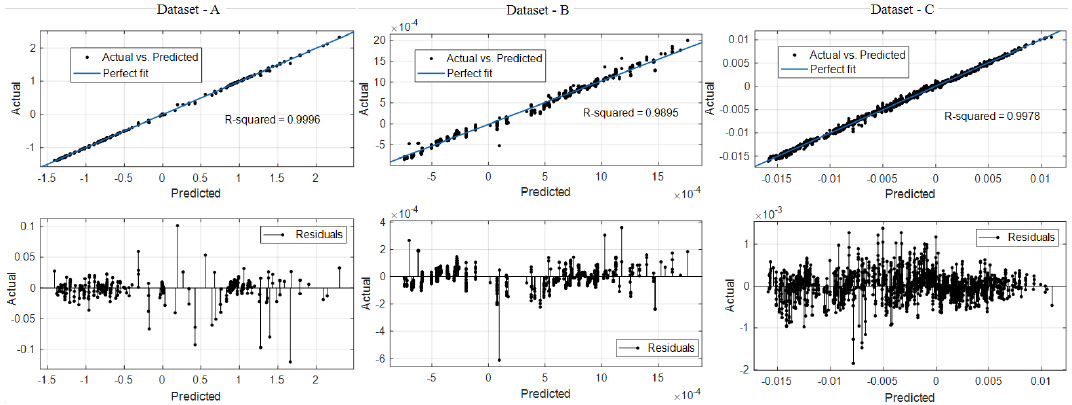
Figure 18. Performance plots of the